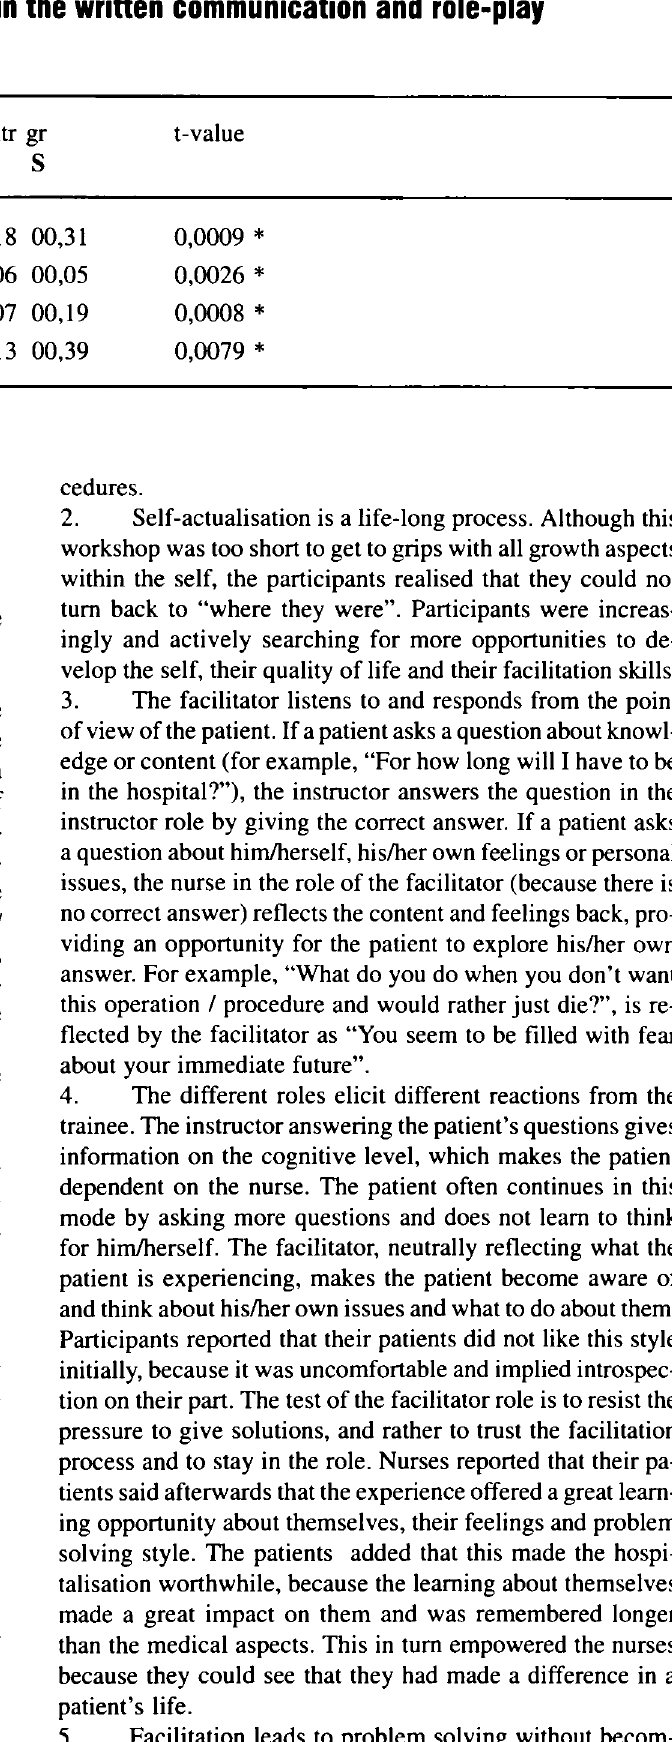
Table 3 : Significance of differences between pre and post scores for the interpersonal skills of facilitation as measured by the Carkhuff scales in the written communication and role-play